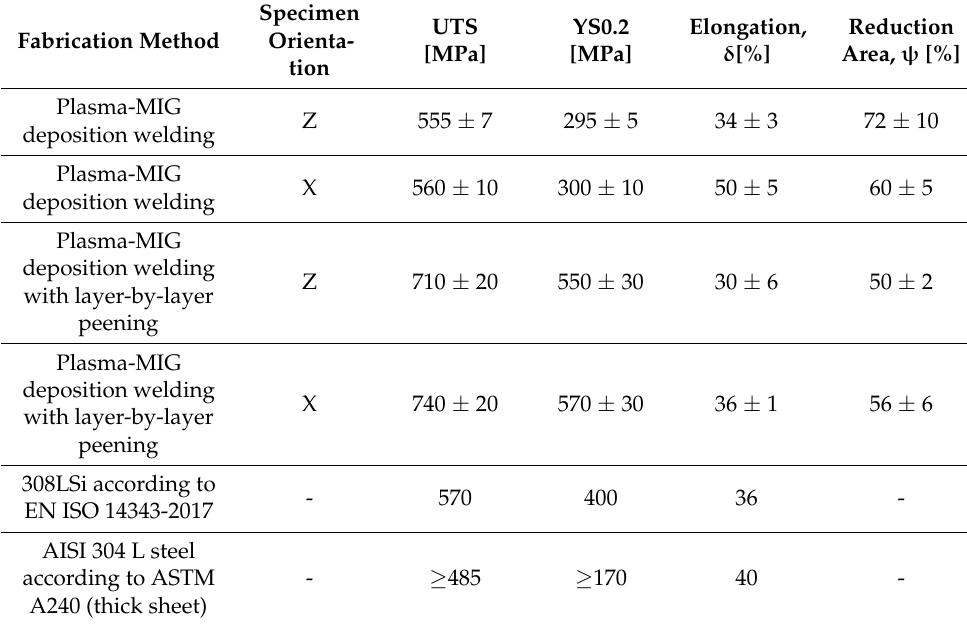
Table 3. Results from the testing of the mechanical